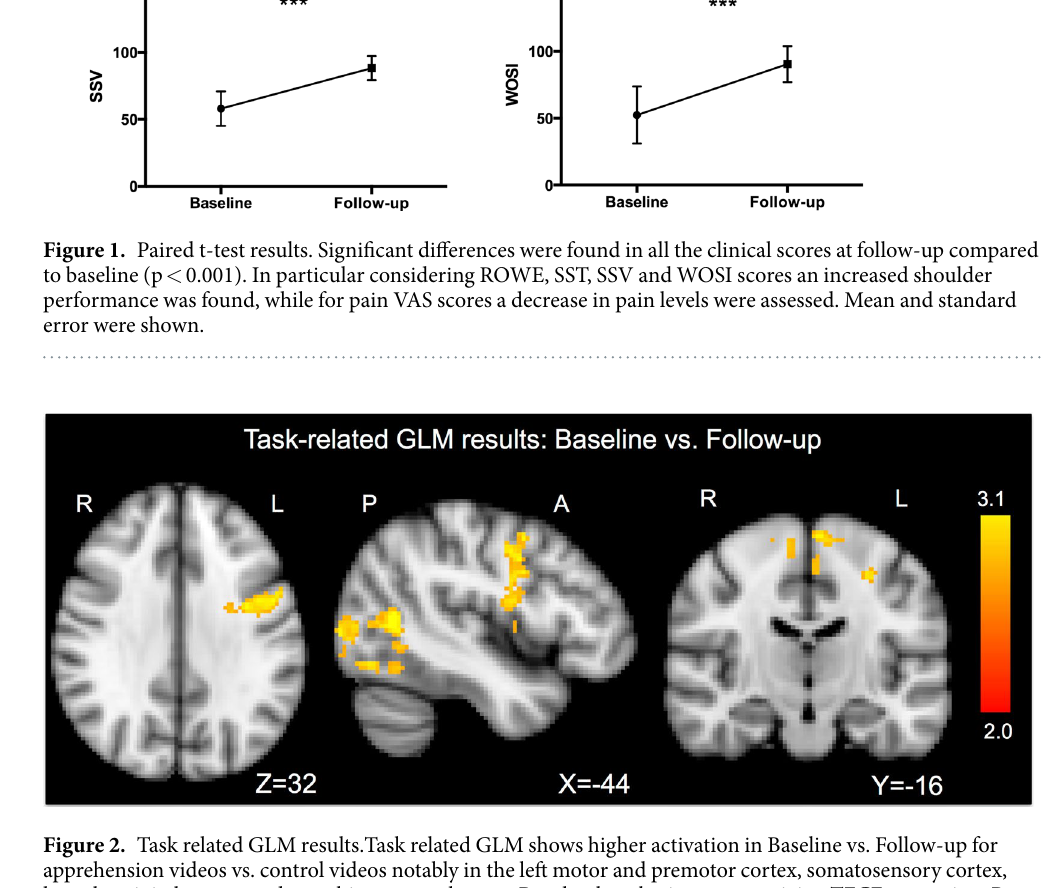
The study design was carried out as following: After screening, all patients presenting shoulder glenoume- ral instability undergo a clinical assessment and fMRI examination twice: at baseline (T1, pre-surgery) and at follow-up (T2 one year after shoulder stabilization surgery). During fMRI examination self-made animation movies (10 seconds) were visually presented. They represented activities potentially triggering apprehension, such as putting the right shoulder at risk for antero-inferior dislocation or arming the shoulder with a javelin, quickly reaching backwards for a seatbelt, and so forth (created by C.G.) 2 . Results